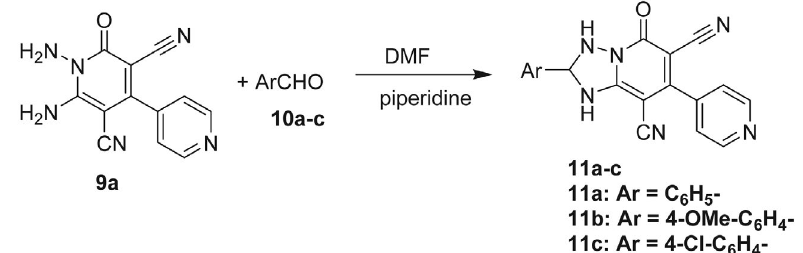
Scheme 5. Synthesis of 2-aryl-5-oxo-7-(pyridin-4-yl)-1,2,3,5-tetrahydro-[1,2,4]triazolo[1,5- a ]pyridine-6,8-dicarbonitriles 11a – c